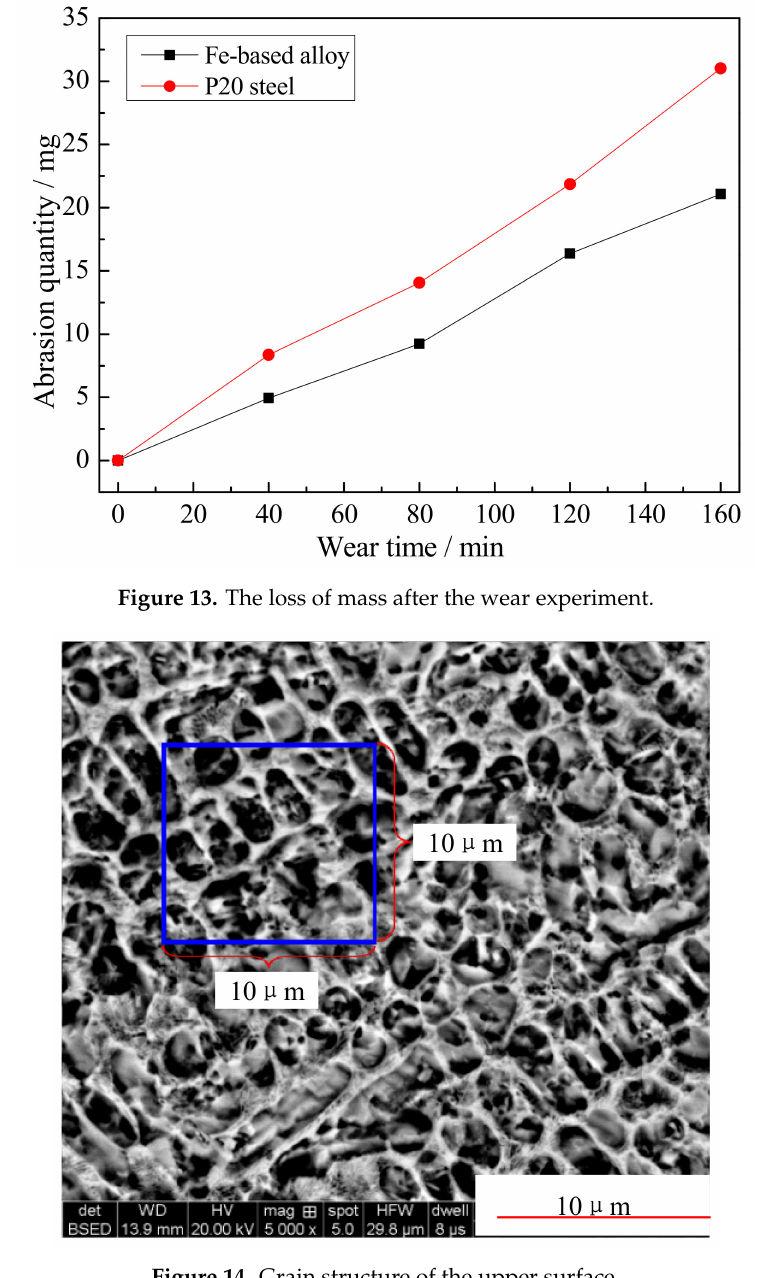
Figure 14. Grain structure of the upper